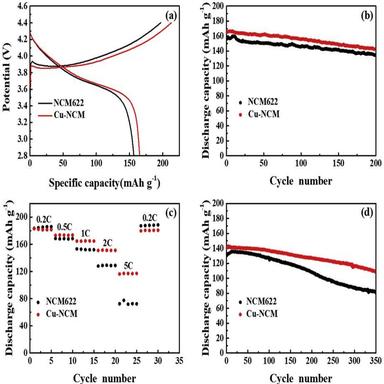
CV curves of NCM622 (a) and Cu-NCM (b) materials under 0.1 mV s1 between 2.7 and 4.7 V for the 1st, 2nd, and 3rd cycles.